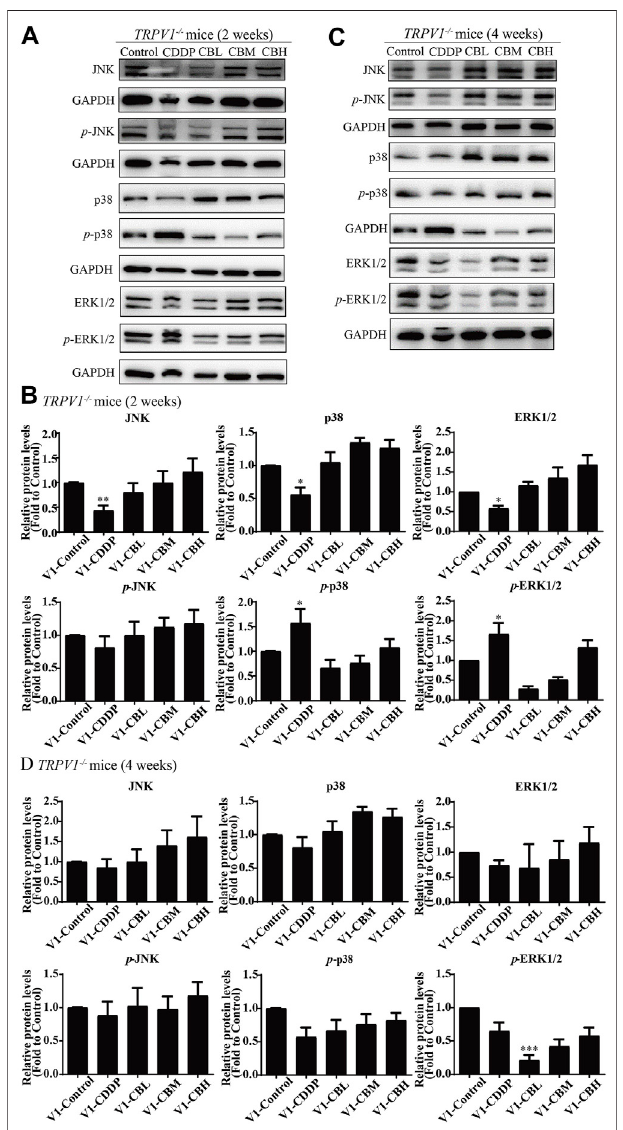
FIGURE 7 | BBR regulates TRPV1-mediated MAPKs signaling pathway in mice. Western blot showed the levels of MAPKs in fl ammatory pathway protein in the DRGs of TRPV1 − / − mice ( n (cid:1) 3). (A,B) After 2 weeks of treatment, BBR up-regulated the downregulation expression of JNK, p38, ERK1/2 induced by CDDP, and inhibited the phosphorylation of p38( F (cid:1) 8.702, p (cid:1) 0.0008) and ERK1/2 ( F (cid:1) 6.228, p (cid:1) 0.0037) in TRPV1 − / − mice. (C,D) There was no signi fi cant difference in MAPKs signaling pathway protein expression in each group of mice after 4 weeks of treatment. Statistical analysis was performed using one-way ANOVA (* p < 0.05, ** p < 0.01, *** p < 0.001, compared with the control group; # p < 0.05, ## p < 0.01; ### p < 0.001, compared with the CDDP group). CBL: CDDP + BBR low dose; CBM: CDDP + BBR medium dose; CBH: CDDP + BBR high dose.